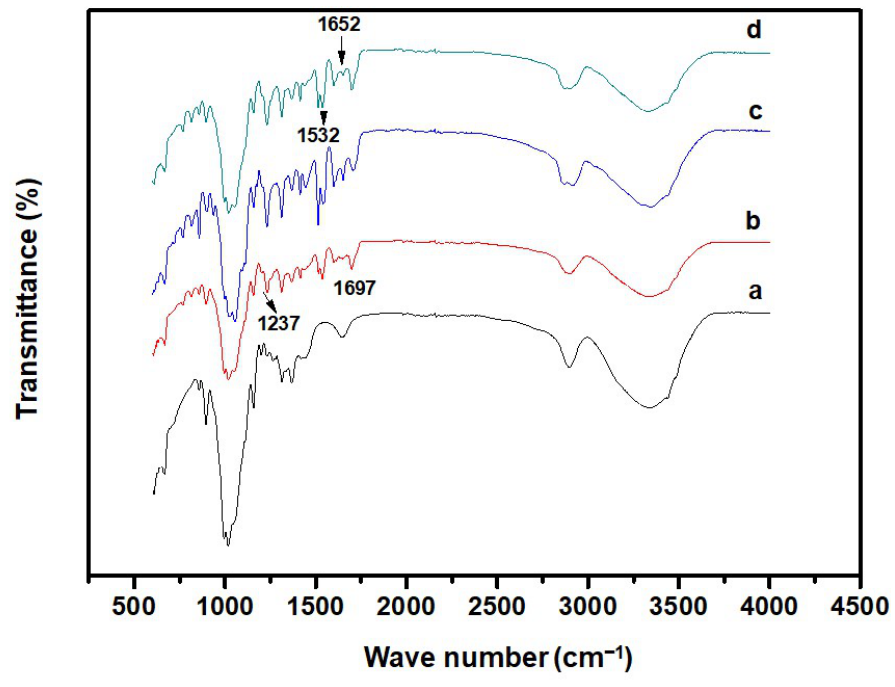
Figure 1. FT − IR spectra of composite films having: ( a ) only CP, ( b ) 1:0.5 CP/PU, ( c ) 1:1 CP/PU, and ( d ) 1:1 CP/PU with 10 wt% curcumin.